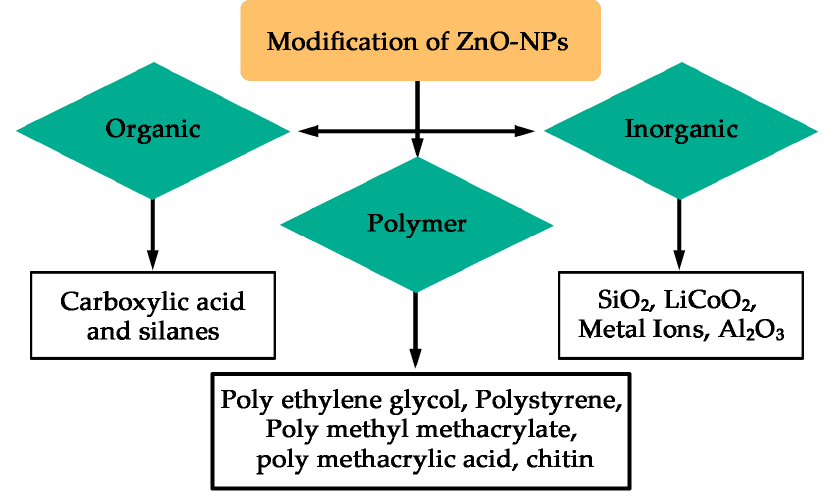
Figure 5. Schematic diagram of the most popular modifications methods of